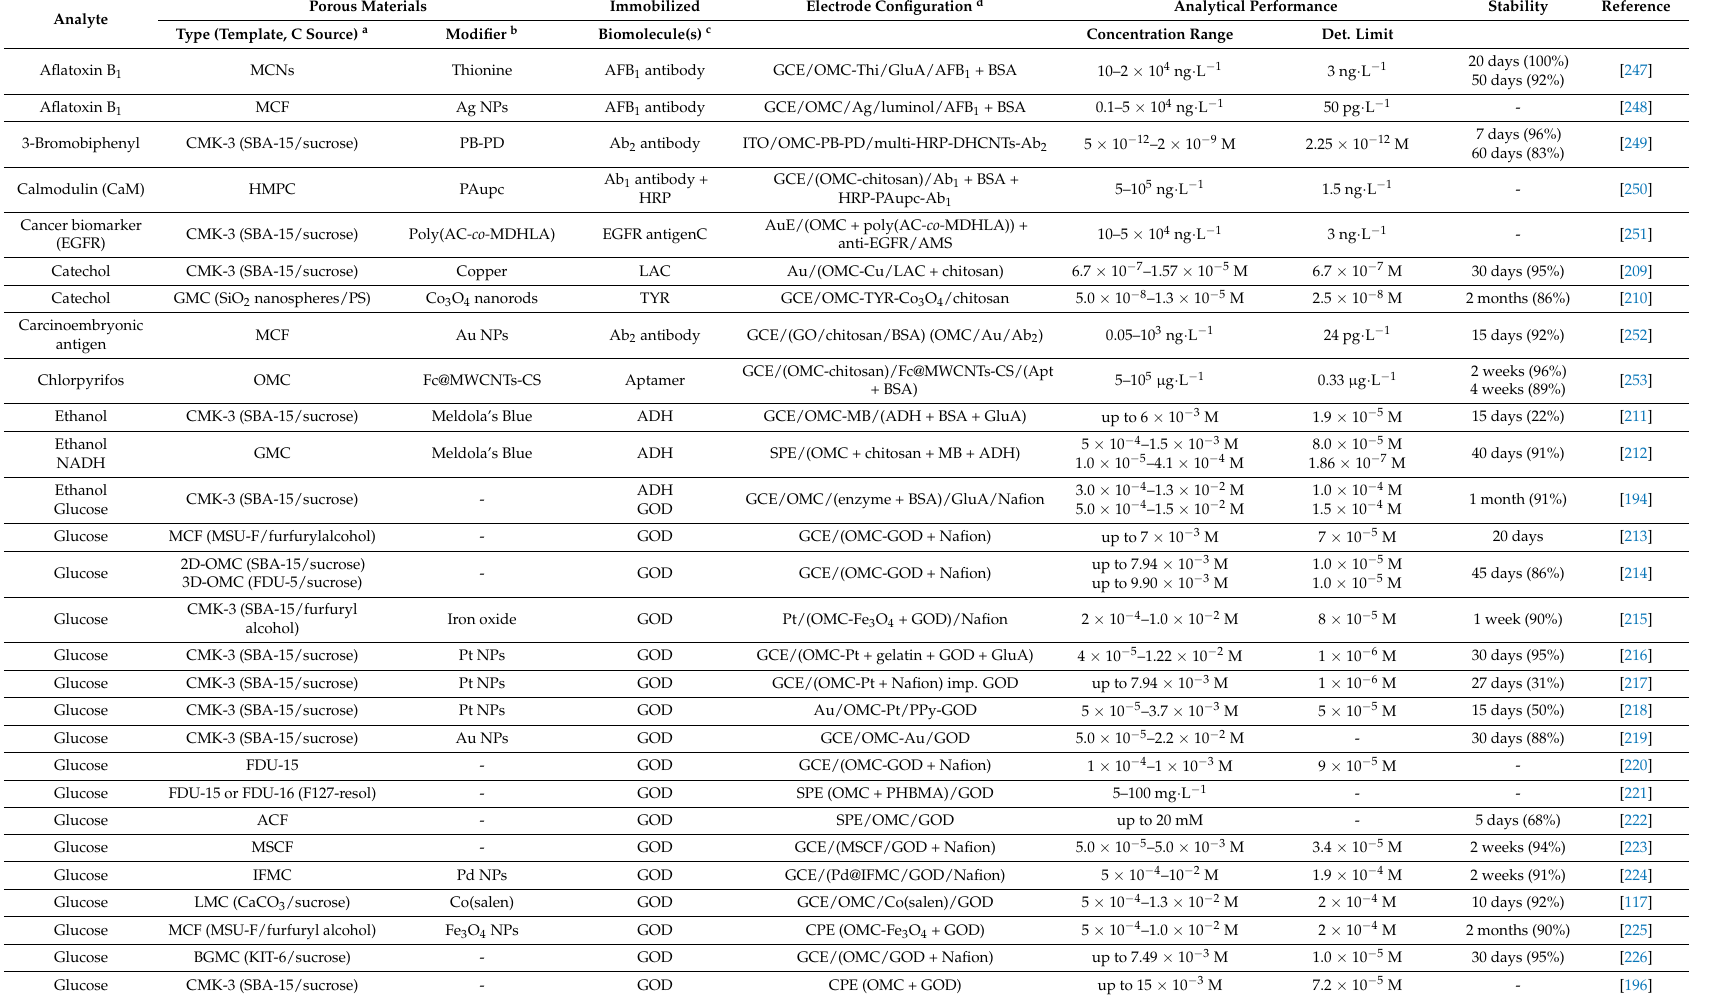
Table 3. Electrochemical biosensors based on electrodes prepared from templated ordered porous carbon materials. Analyte